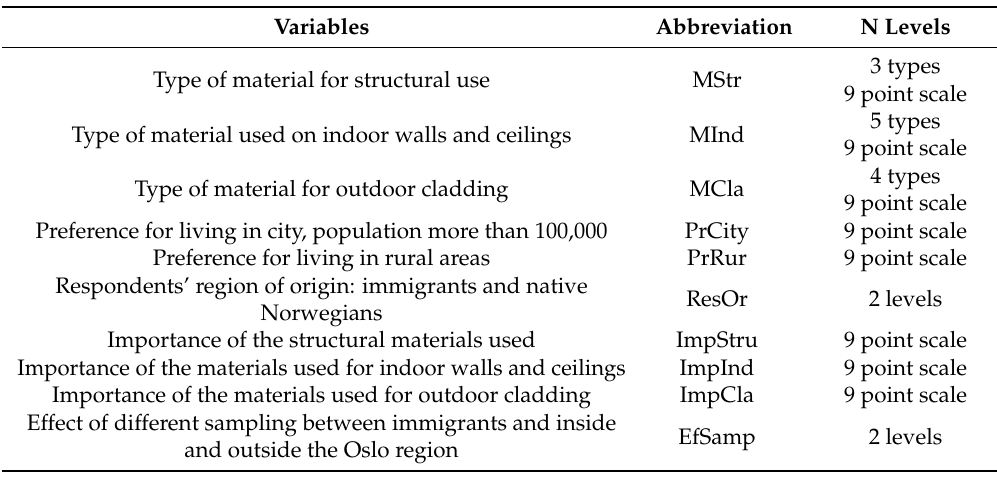
Table 2. Variable definitions and abbreviation